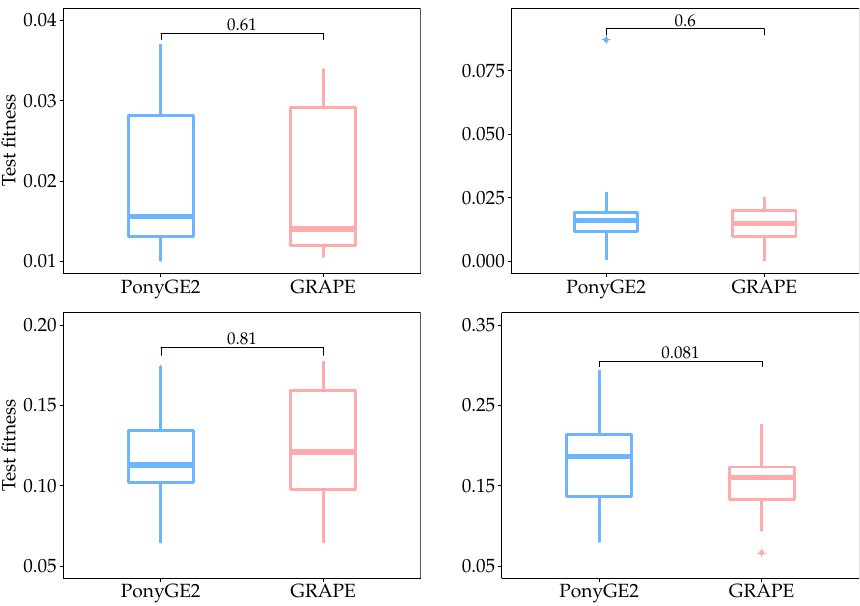
Figure 5. Test fitness score achieved by the best individual of each run using GRAPE and PonyGE2: Vladislavleva-4 ( top left ), Pagie-1 ( top right ), Banknote ( bottom left ) and Heart Disease ( bottom right ).